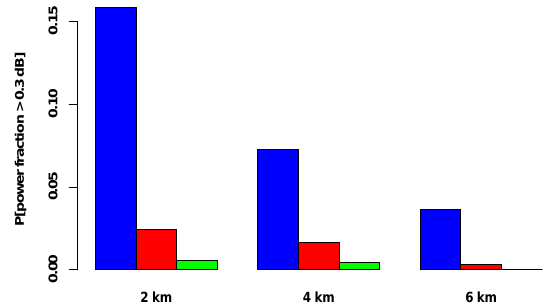
Figure 5. Probability that the solar hit power exceeds the far range power by 0.3dB. The power determined by mean filtering is de- noted by blue, and the power determined by median filtering by red. The green bar indicates solar power determined by the mean filtering when the filtering window is determined from points above 8km altitude. The probability is given for start altitudes of 2, 4, and